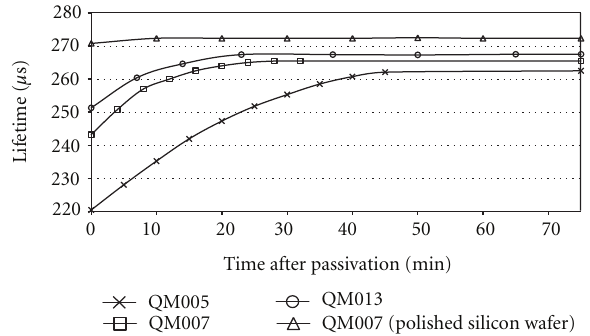
Figure 5: Comparison of the passivation startup between QM005, QM007, and QM013 for textured wafers.